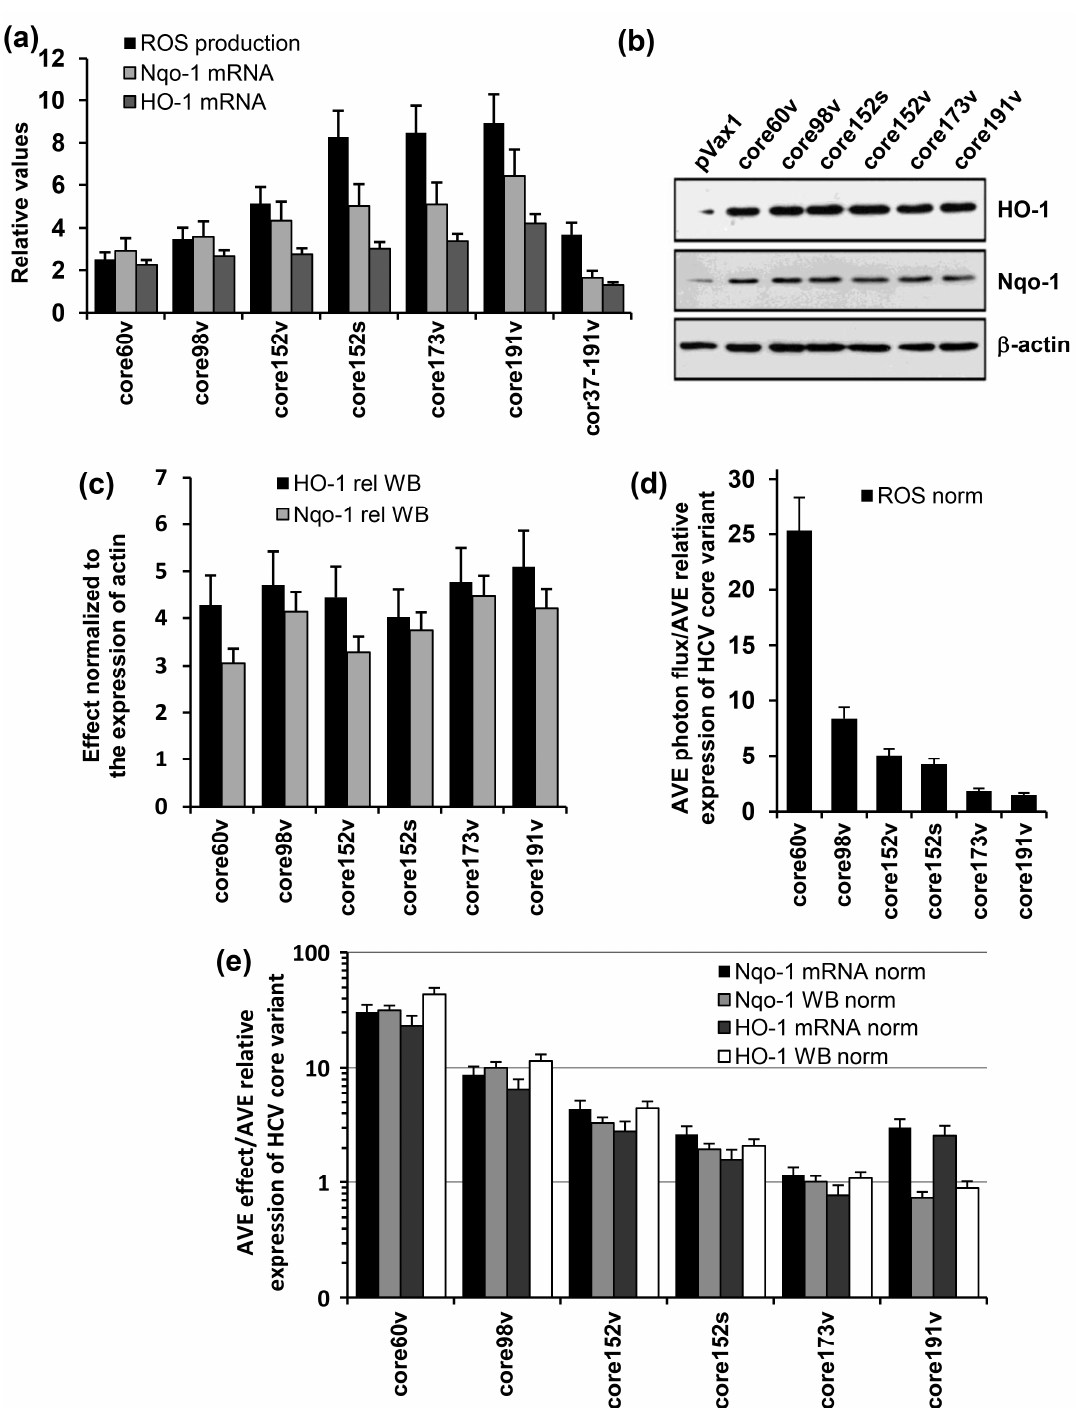
Figure 4. The induction of oxidative stress and oxidative stress response by variants of HCV core genes. ( a ) HEK293 cells were transiently transfected with plasmids core1-60v, core1-98v, core1-152v, core1-191v, core37-191v DNA based on the viral gene sequence, or core152s DNA based on the synthetic core1-152 encoding DNA, or empty vector pVax1. After 30 h, cells were assessed for the production of ROS with an oxidation sensitive dye dichlorofluoresceine diacetate (DCFHDA), and after 48 h, for activation of transcription of Phase II detoxifying enzymes Nqo1 and HO-1; ( b ) expression HO-1 (upper